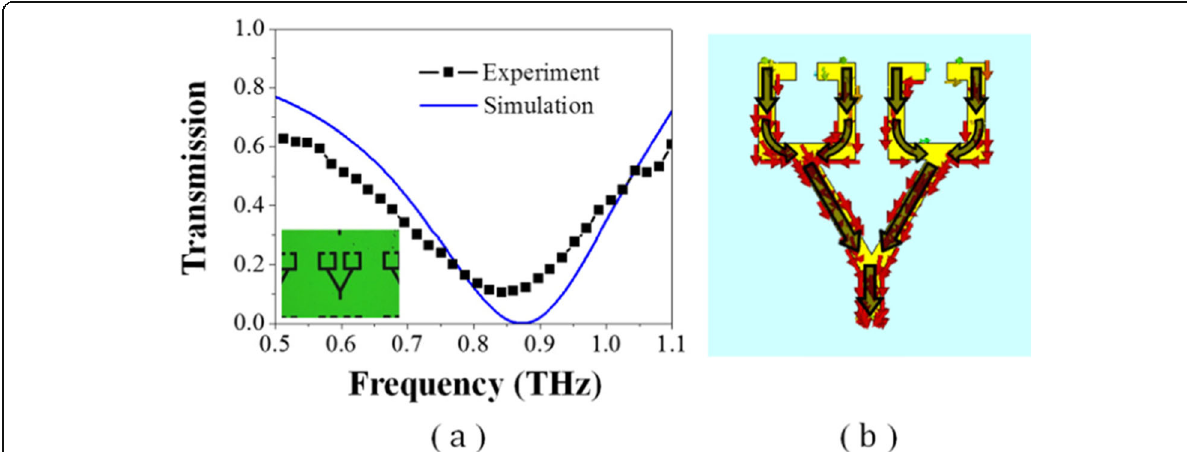
Fig. 7 a Simulated and measured spectra of the conductively coupled terahertz metamaterial in which the junctions are located on the vertical center line of the SRRs. b Surface currents of the corresponding